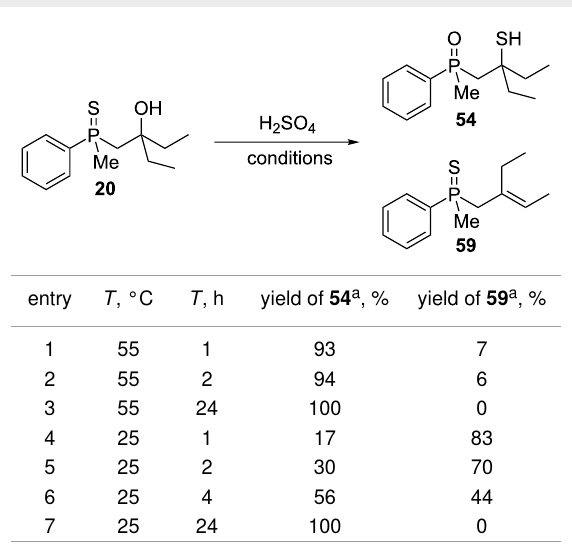
Table 4: Control experiments under Brønsted acid